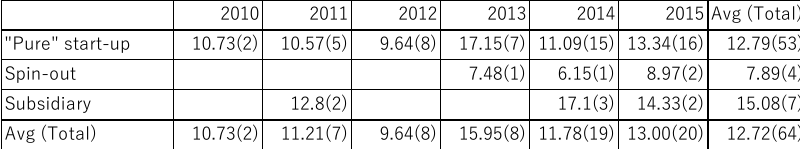
Note: Numbers in parentheses denote numbers of